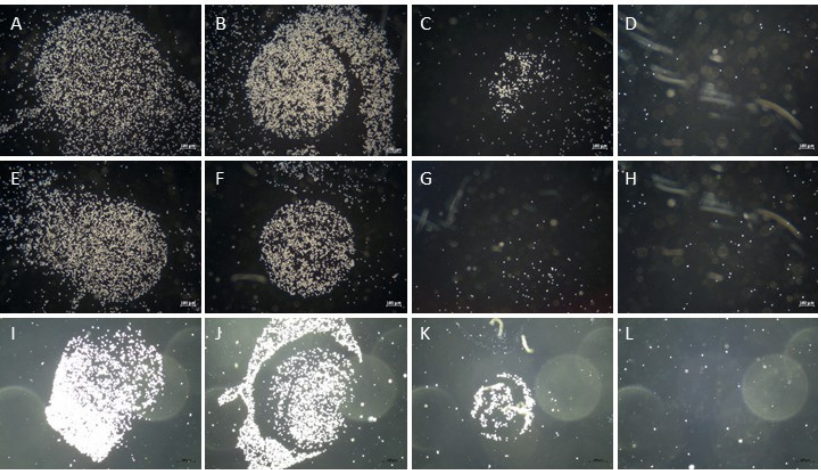
Figure 7. Attachment of cells after WJ injection. pADSCs were harvested and subjected to cell at- tachment assays (controls ( A – D ) after WN injection ( E – H ) and after WJ injection in capture fluid ( I – L )). All populations attached to collagen at 1E02 ( A , E , I ) and 1E03 ( B , F , J ) dilutions, respectively. Not injected control cells slightly attached to collagen at 1E04 ( C ), while pADSCs after WN injection failed to attach ( G ). Cells after WJ injection maintained some attachment capacity ( K ). The interaction with BSA served as negative controls ( D , H , L ). Abbreviations: WN—Williams needle,